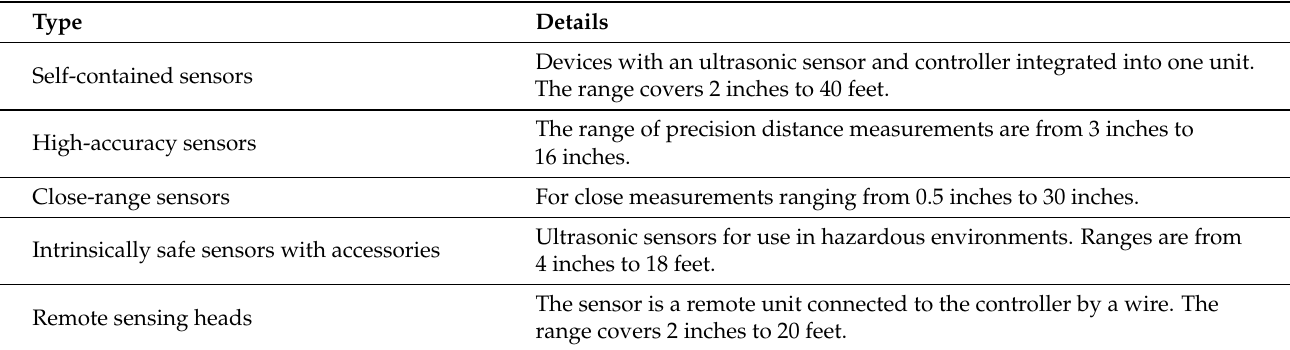
Table 8. Advanced ultrasonic